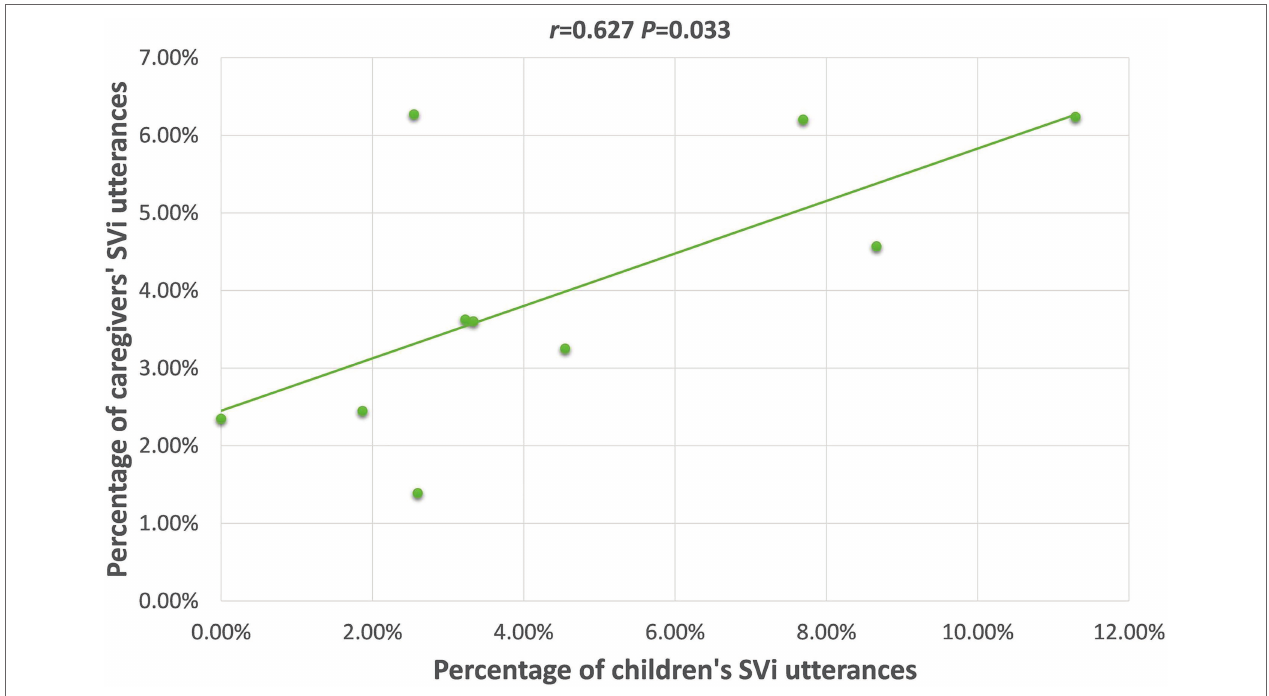
FIGURE 2 | Scatterplot of 26 m TD children’s and caregivers’ SVi